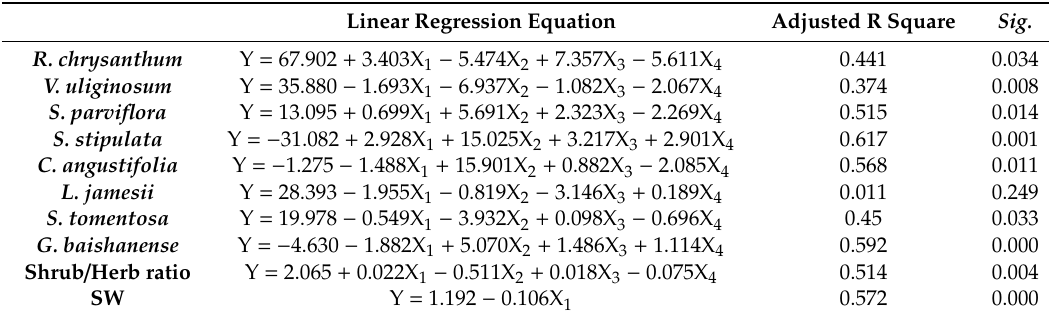
Table 5. Multivariable linear regression of the eight dominant species and different environmental factors.